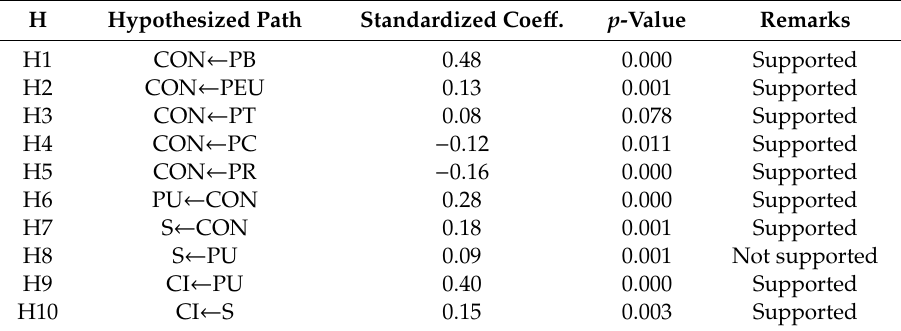
Table 5. Statistical analysis of path coe ffi cients (original